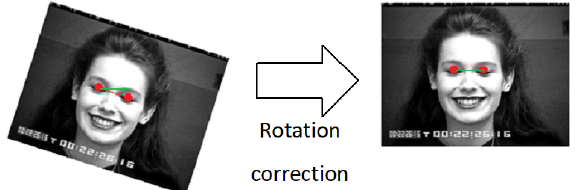
Figure 8. Rotation correction on a face from the CK+ database.